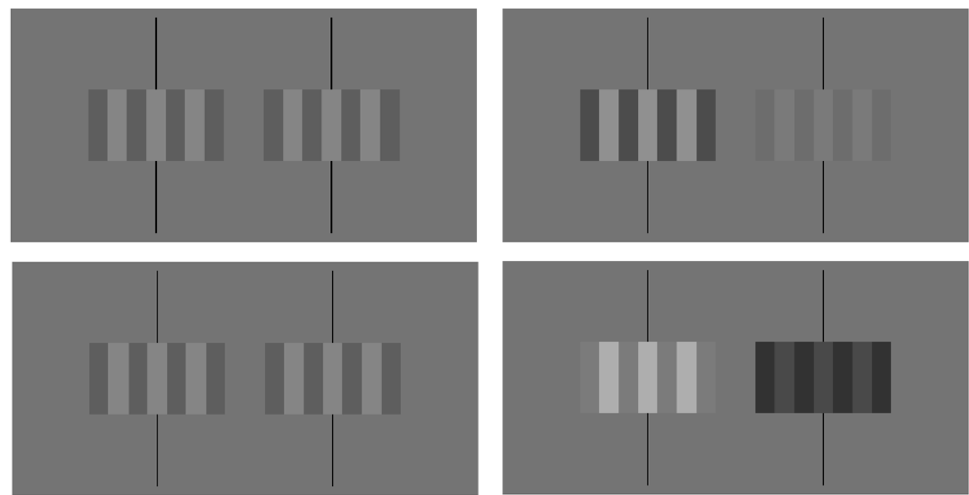
Figure 2. Stereograms with binocular fixation lines of rectangular-wave gratings that have zero disparity (top left), a geometric disparity created by wider bars on the left side grating (bottom left), a contrast (top right), or a luminance (bottom right) disparity corresponding to a dichoptic contrast modulation of approximately 0.6. Either crossed or uncrossed fusion is appropriate. The bars of the zero disparity stimulus (top left) should appear to be in the fronto-parallel plane. For the other three stimuli that contain disparities (geometric, contrast, and luminance), the lighter bars of the static stimuli will appear to rotate with their right edges closer to the viewer. If crossed fusion is used, the lighter bars of the fused image will appear to rotate with their left edges closer to the viewer (see Reference [3] Figure 1 for a 100%-contrast